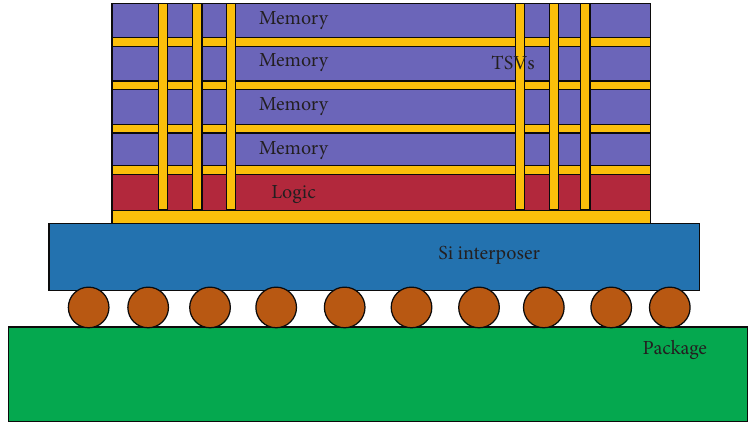
Figure 1: 3D-IC using